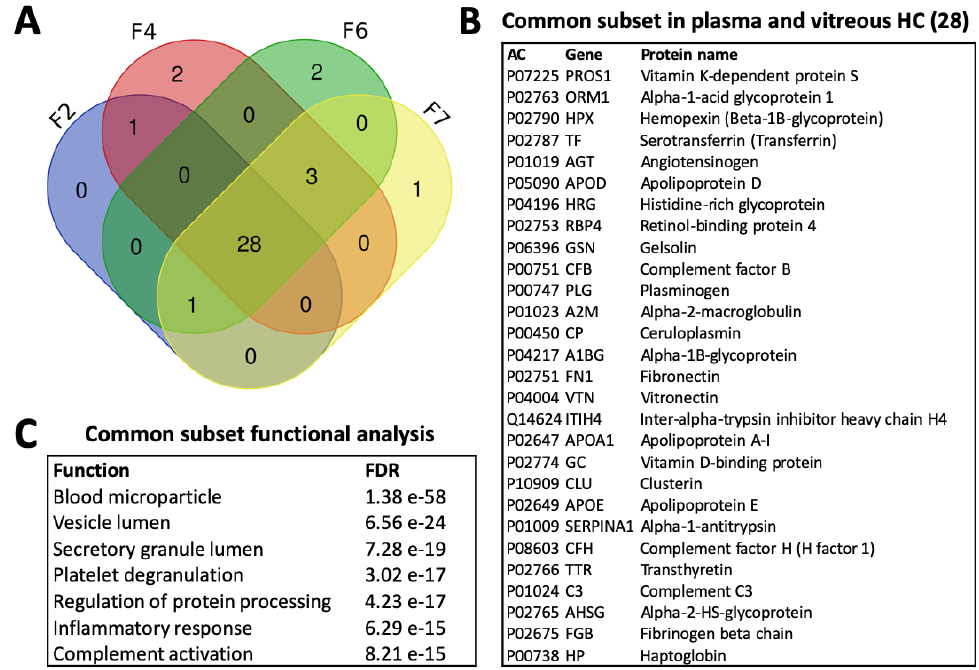
Figure 8. ( A ) Venn diagram of the commonalities between all proteins identified in the plasma and vitreous HCs of liposome formulations F2, F4, F6, and F7 without accounting for relative enrichment. ( B ) Proteins of the common subset. ( C ) Enriched biological functions in the common subset. AC: protein accession code; FDR: false discovery rate.